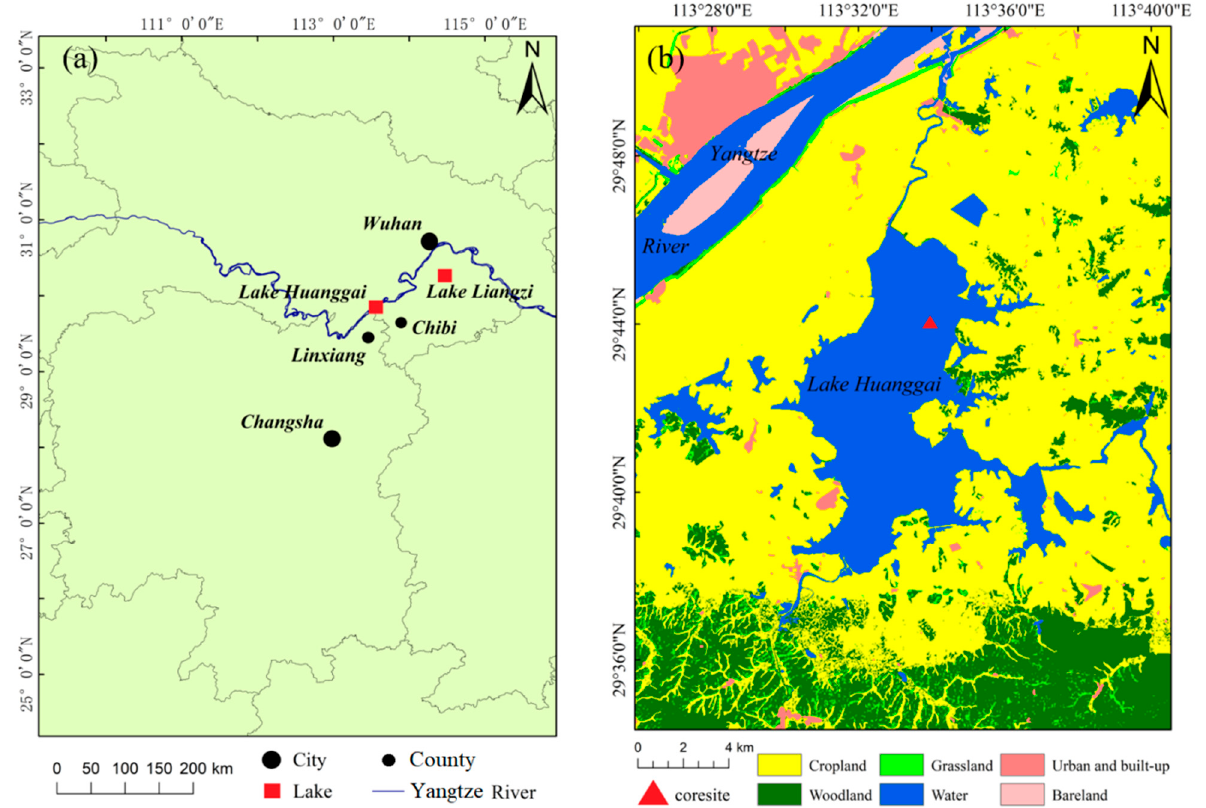
Figure 1. Geographical location of Huanggai Lake with ( a ) the map exhibiting two lakes, Huanggai Lake and Liangzi Lake, along the Yangtze River; ( b ) the land use of Huanggai Lake Basin.